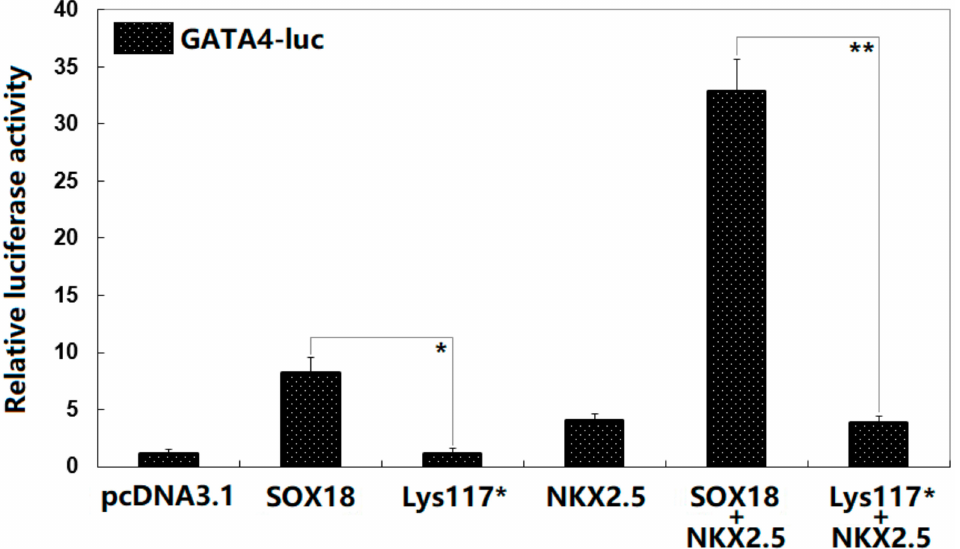
Figure 5. Synergistic activation between SOX18 and NKX2.5 abrogated by the variation. Dual- reporter gene measurement of the synergistical transactivation of the NKX2.5 -promoter activity in cultured HeLa cells by SOX18 and NKX2.5 indicated that the synergy was abolished by the Lys117* variation. For each expression plasmid, three independent in vitro experiments were carried out in triplicate. A Student’s t -test was employed to compare two groups. Herein, * and ** mean * p < 0.001 and ** p < 0.0001, in contrast to the corresponding wild-type